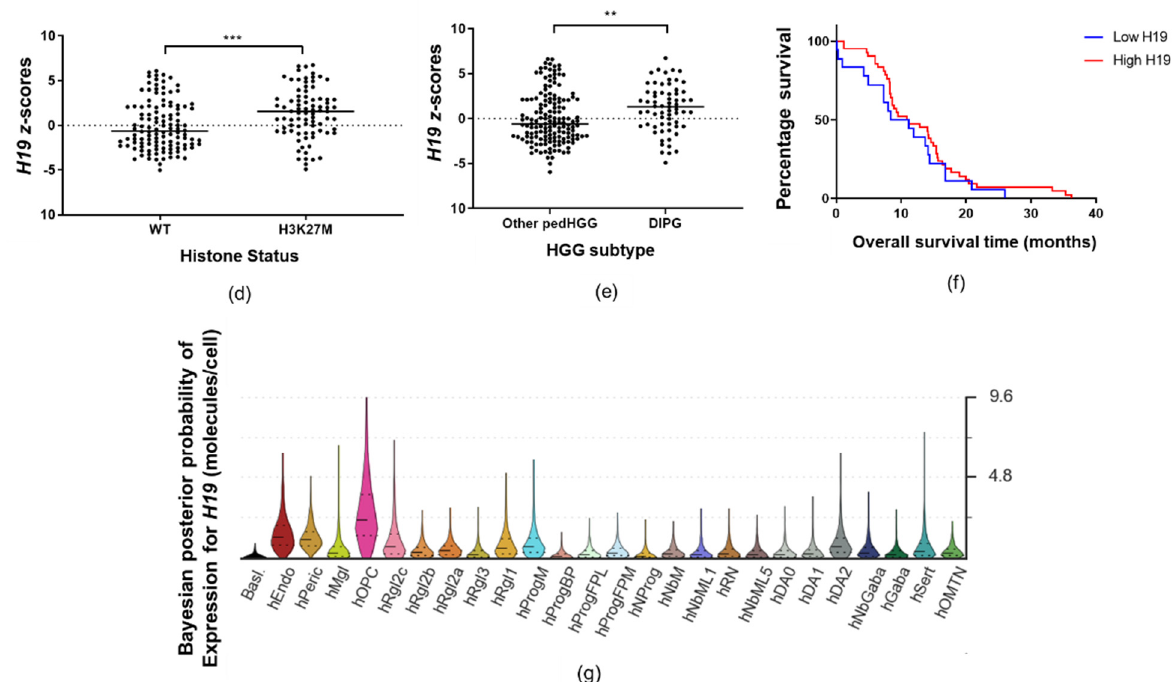
Figure 1. H19 is associated with DIPGs ( a ) Clinical expression data of H19 in the “Allis-45-custom-ilmnht12v4” dataset analysed on the R2 platform for normal brain ( n = 10) and DIPG tissues ( n = 35) [23,24]. ( b ) Clinical expression levels of H19 in the “ Paugh-37-MAS5.0-u133p2 ” dataset analysed on the R2 platform for normal brain ( n = 2) and DIPG tissues ( n = 27). ( c ) H19 expression in patient samples with pedHGGs located in either hemisphere ( n = 107), midline ( n = 46), or brainstem ( n = 65) analysed with the paediatric Cbioportal platform [25]. ( d ) H19 expression in patient samples with pedHGGs either non-mutated/WT ( n = 118) or carrying a H3K27M mutation ( n = 83) analysed with the paediatric Cbioportal platform. ( e ) Expression of H19 in histologically confirmed DIPG samples ( n = 65) or other pedHGGs ( n = 153). ( f ) Kaplan–Meïer curve for overall survival time (months) of DIPG patients with either high or low levels of H19 (median expression cut-off). ( g ) Violin plot showing the Bayesian posterior probability of H19 expression in different cell types during neurodevelopment. Data in ( a , d , e ) were analysed by an unpaired two-tailed t -test with Welch’s correction. Data in ( c ) were analysed with one-way ANOVA and Dunnett’s post-hoc test for multiple comparison. All data are shown as mean ± SD. Significant values are ** p < 0.01, *** p < 0.001. NS = non-significant.